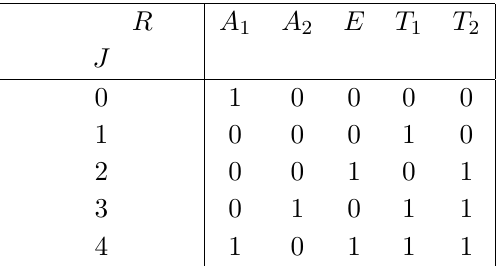
Table 3 . Subduced representations R of the octahedral group in terms of the continuum represen- tations J of the rotational group, from